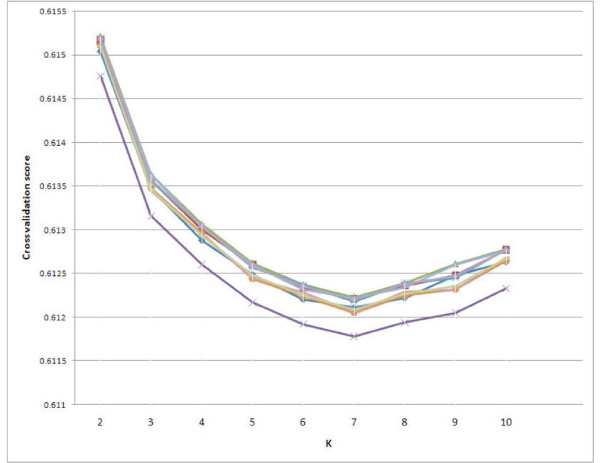
Ten-fold cross-validation of K = 2 through K = 10 clusters from ADMIXTURE analysis with 10 randomly selected subsets of n = 175 individuals from the Ashkenazi Jewish (AJ) cohort, combined with HGDP subjects as indicated in Figure 1. The x-axis represents the number of clusters (K) in the model and the y-axis represents cross-validation score (lower scores represent better fit of the model to the data). Ten different colors represent different runs.